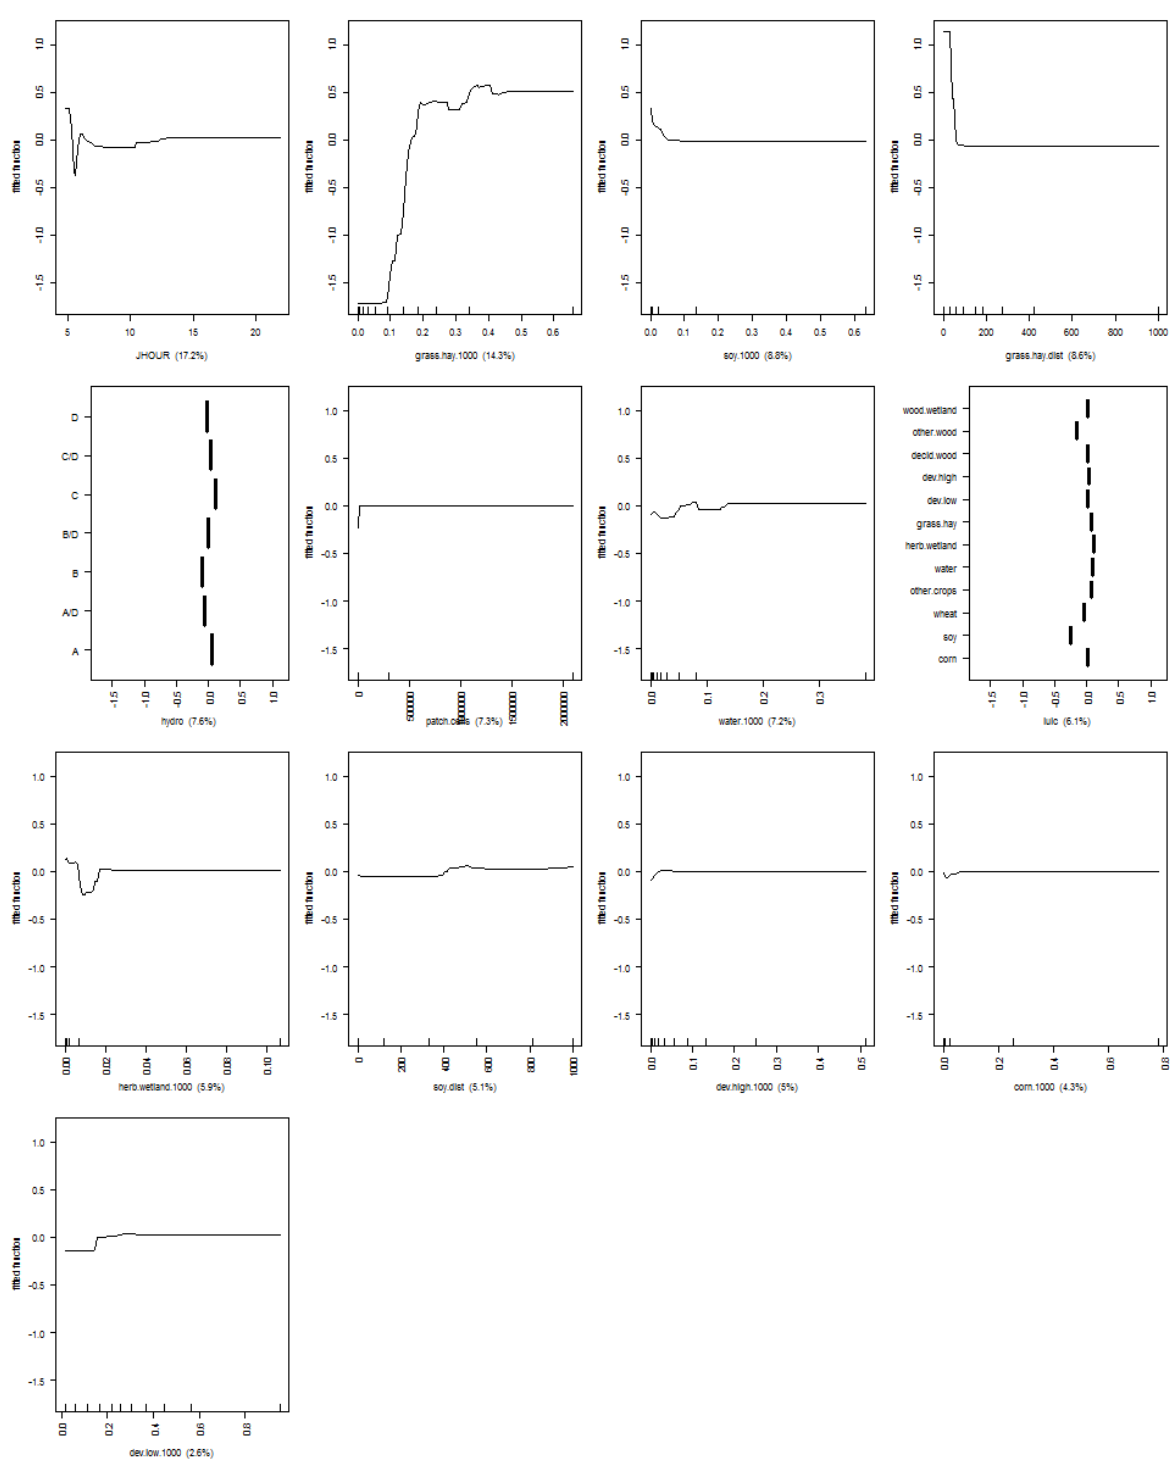
Figure A1.4d. Response curves for Henslow’s